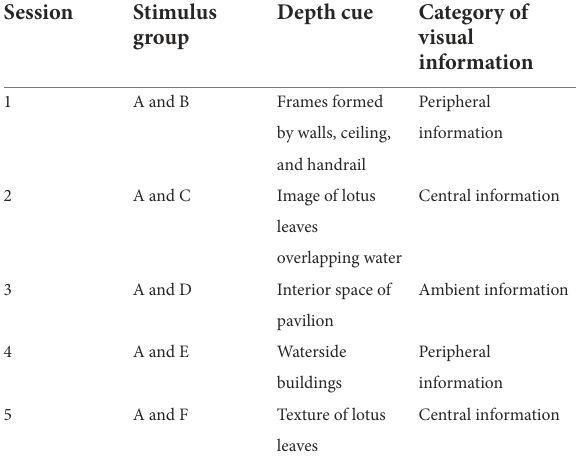
divided into five groups. In each session, stimulus A2 (see Figure 2) served as the standard stimulus (depth value: 100). The comparative stimuli included stimulus group A in the other position (A1, A3) and one of the stimulus groups. For example, session 1 included stimulus groups A (A1 and A3) and B (B1, B2, and B3) as comparative stimuli, which were rated and assigned a number by comparing the standard stimulus A2.